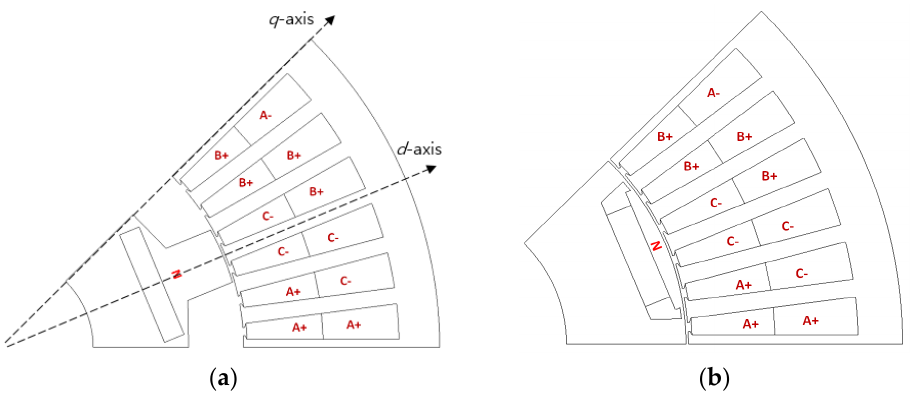
Figure 3. Cross-sectional views of the two IPM machines: ( a ) FI-IPM machine; ( b ) FW-IPM (Flat 2) machine.